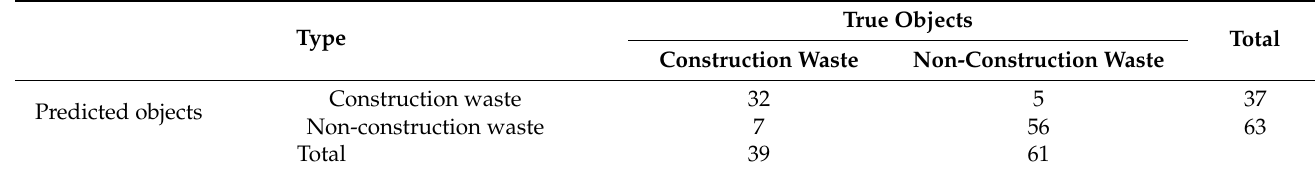
Table 5. The confusion matrix of area B.